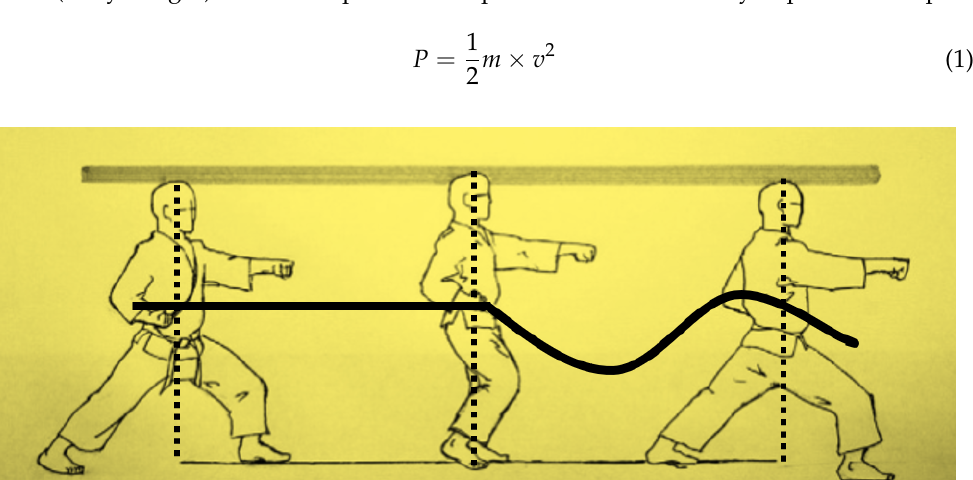
Figure 3. The Taekwondo sine-wave punch—image based on article in